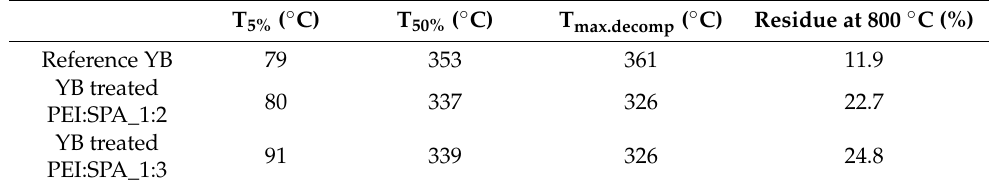
Table 5. Results from TG and DTG curves for reference YB and YB treated with different PECs